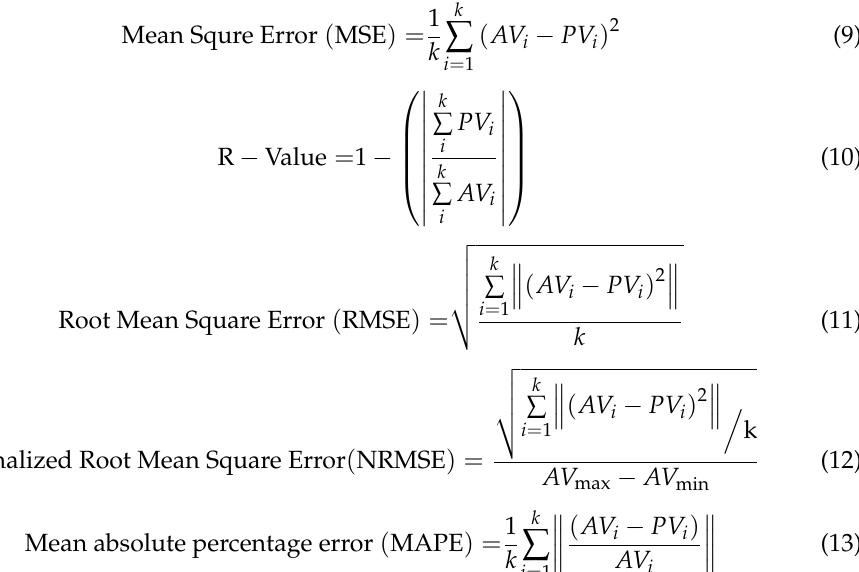
Figure 10. Confusion matrix corresponding to DBN: ( a ) confusion matrix showing numerical values ( b ) TPR and FNR (in percentages). Table 10 . Performance of data-mining techniques in fault detection with noisy conditions.